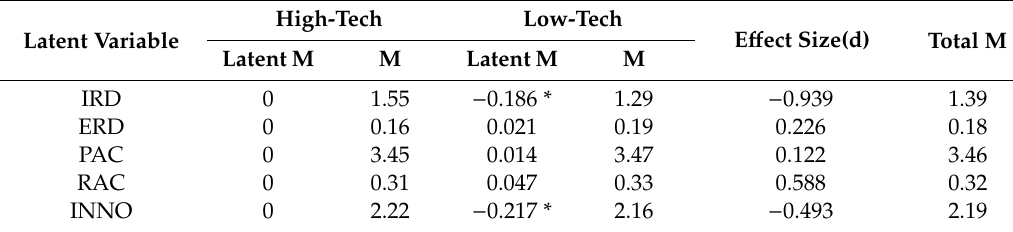
Table 10. Di ff erence analysis of latent mean variables.